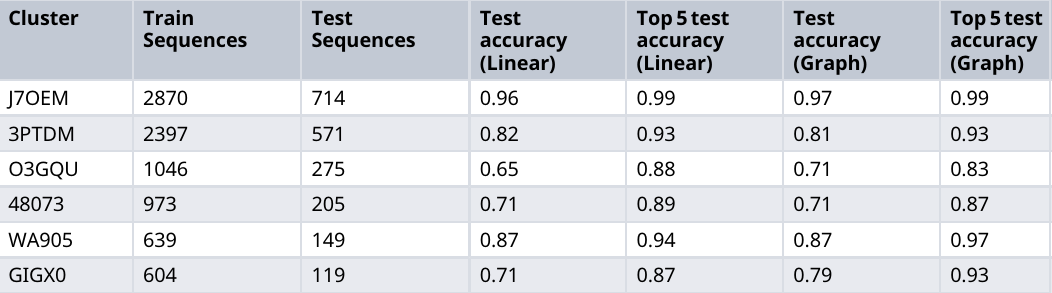
Table 1. Summary of PanOriginSV prediction accuracy. Benchmarking results on large clusters obtained from MMseqs2. For a single cluster, 25% of sequences were held out and used as the testing set. The accuracy of the top